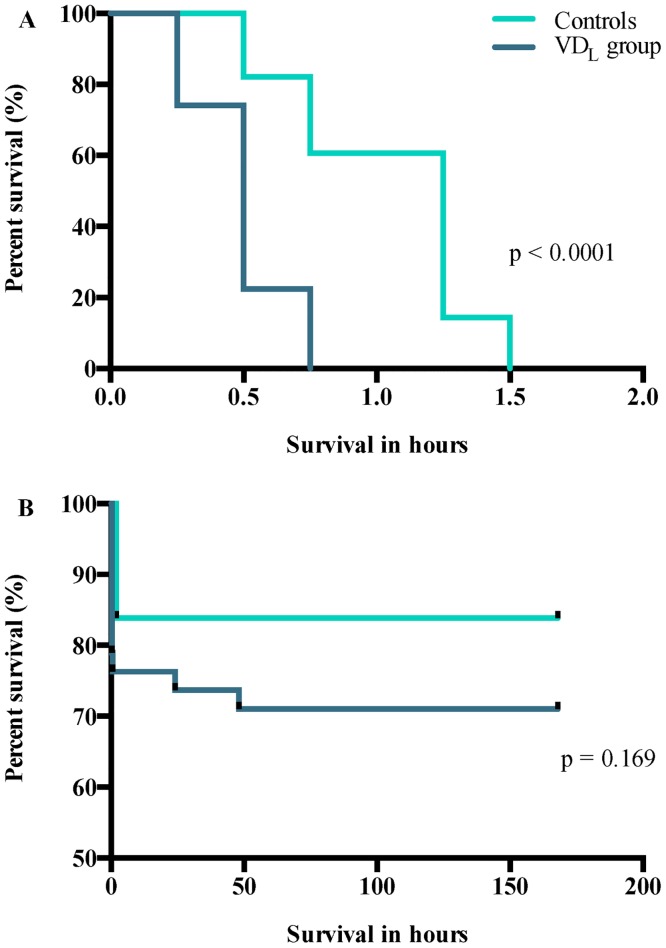
Survival-rate in hours after birth.Kaplan-Meier survival analysis of both A) E19 (VDL group (n = 58); control group (n = 28)) and B) E22 (VDL group (n = 38); control group (n = 31)) pups. Comparison of survival curves using log-rank (Mantel-Cox) test.